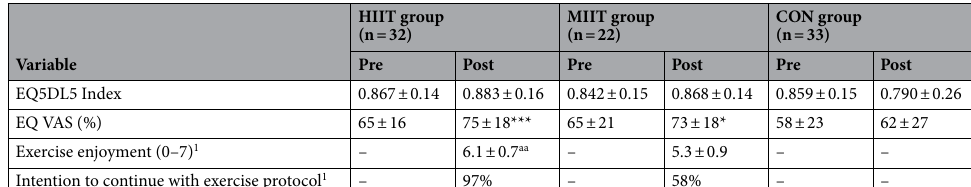
– – – – Table 6. Self-reported health-related quality of life pre- and post-intervention. Values are expressed as mean ± SD. HIIT high-intensity interval training group, MIIT moderate-intensity interval training group, CON control group, VAS visual analogue scale. 1 , only assessed post-intervention. *( p < 0.05), ***( p < 0.001), significantly different from pre-intervention. aa ( p < 0.01), significant difference HIIT vs. MIIT.